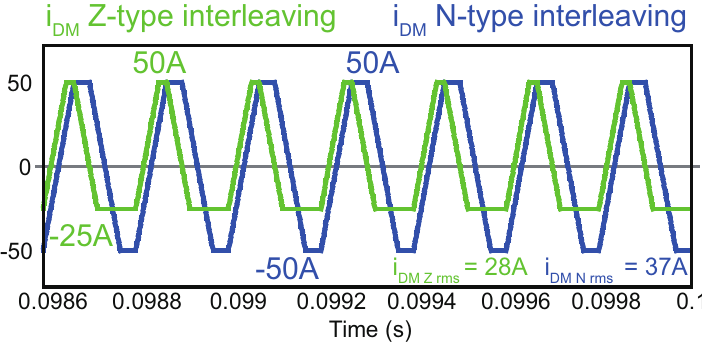
Figure 15. Simulation analysis circuit diagram.